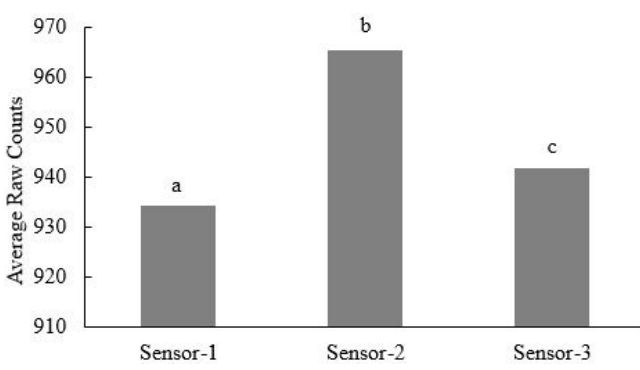
Figure 2. Sensor-to-sensor variation (Senor-1, Sensor-2, and Sensor-3) of sensor readings based on the results of the Tukey HSD test. Sensors not sharing the same letter are significantly different at p < 0.05.